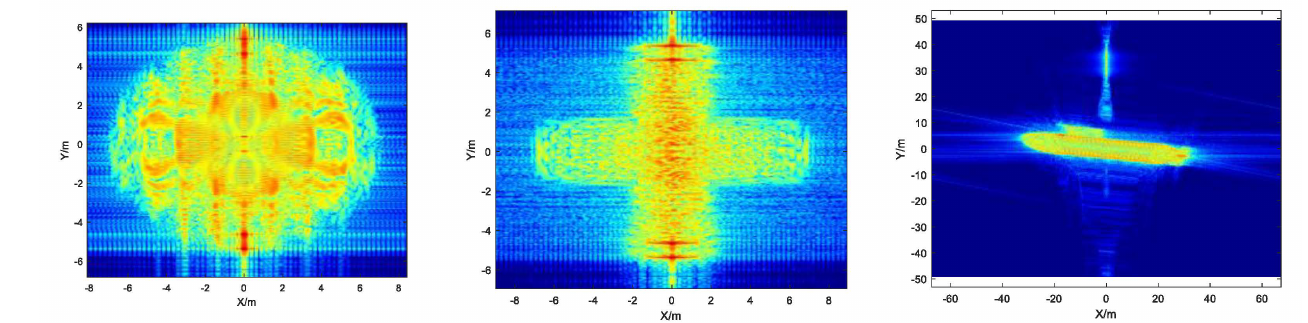
Figure 11. ISAR imaging results of the time domain echo signals of different